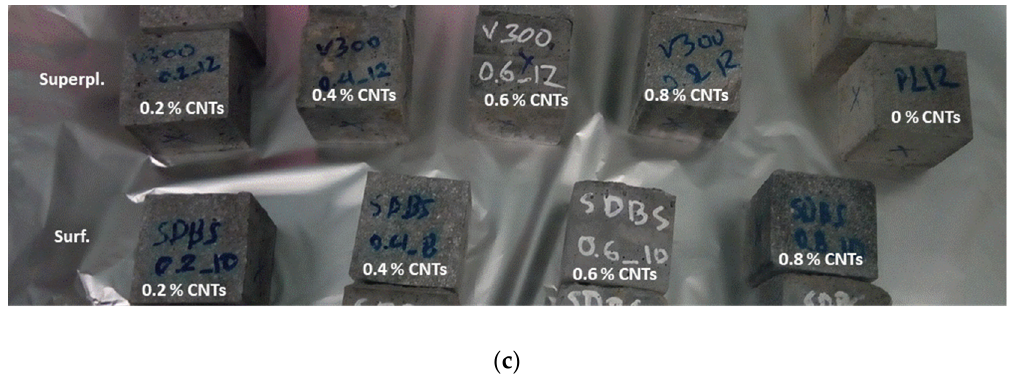
Figure 1. Pictures of un-modified and CNT-modified specimens ( a ) before, ( b ) after F-T and ( c ) after S-A exposure.